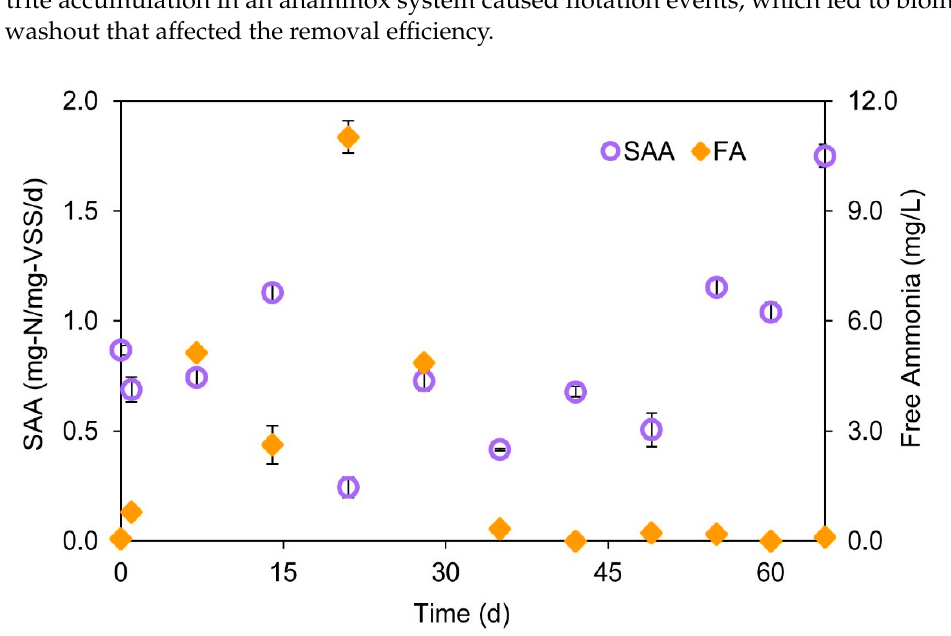
Figure 7. Specific anammox activity (SAA) and free ammonia (FA) concentration during the long-term caffeine dosing.